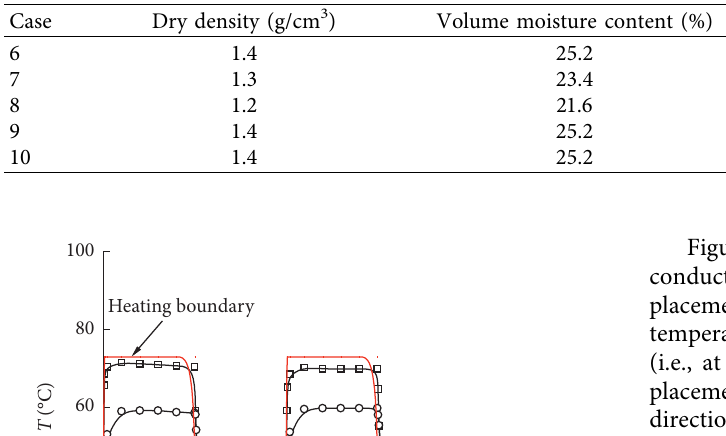
Table 2: Test schemes for heavy metal transfer.